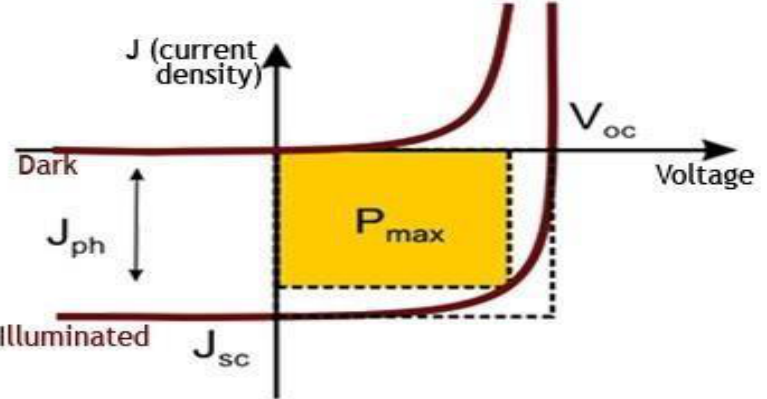
Figure 2. Typical (I-V) curves for an Organic Photo Voltaic (OPV) (dark and illuminated).